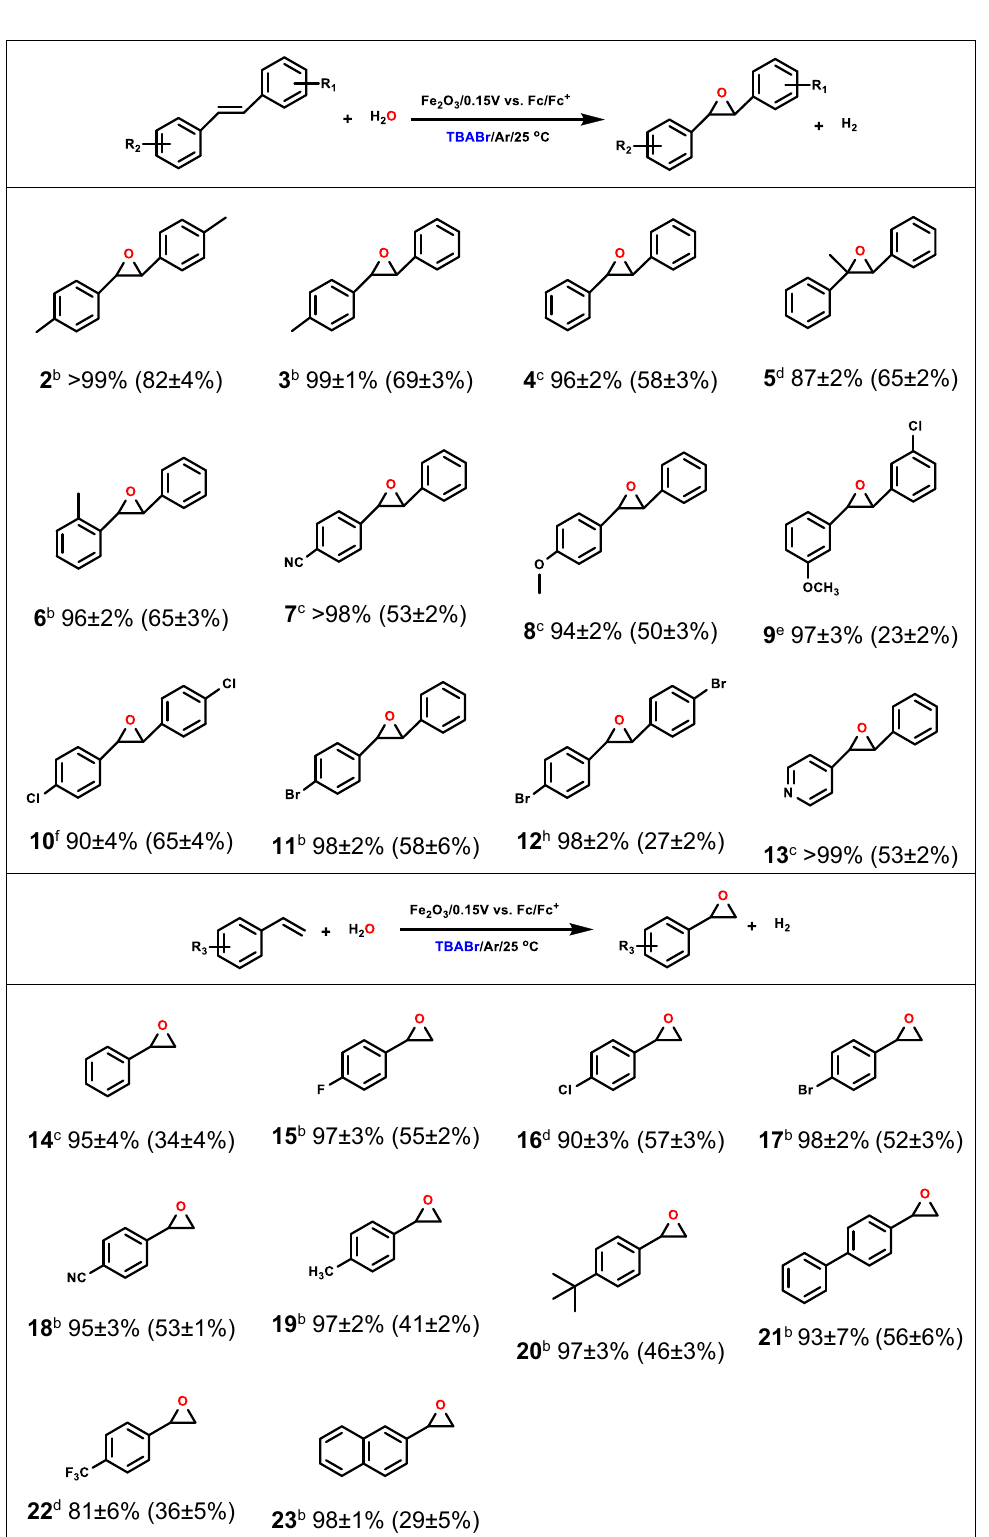
Table 1 | Scope of the substituted stilbene and styrene substrates for the PEC bromine-mediated alkene epoxidation